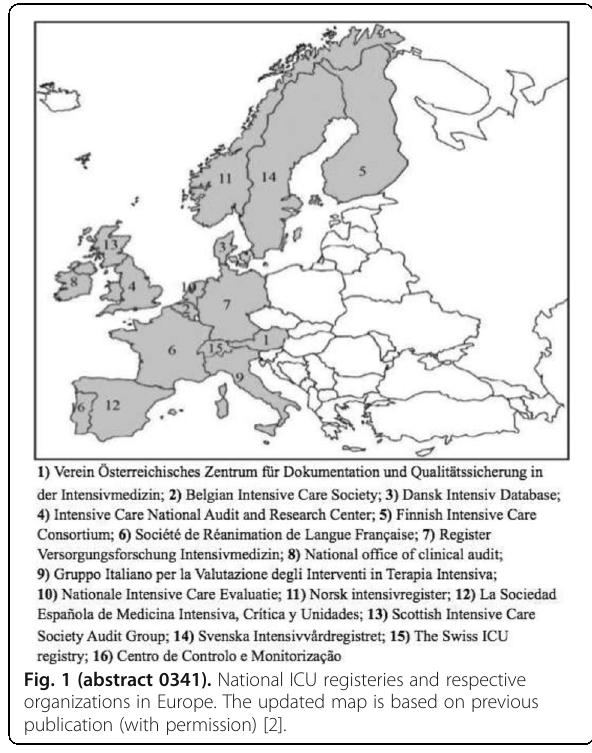
Fig. 1 (abstract 0341). National ICU registeries and respective organizations in Europe. The updated map is based on previous publication (with permission)